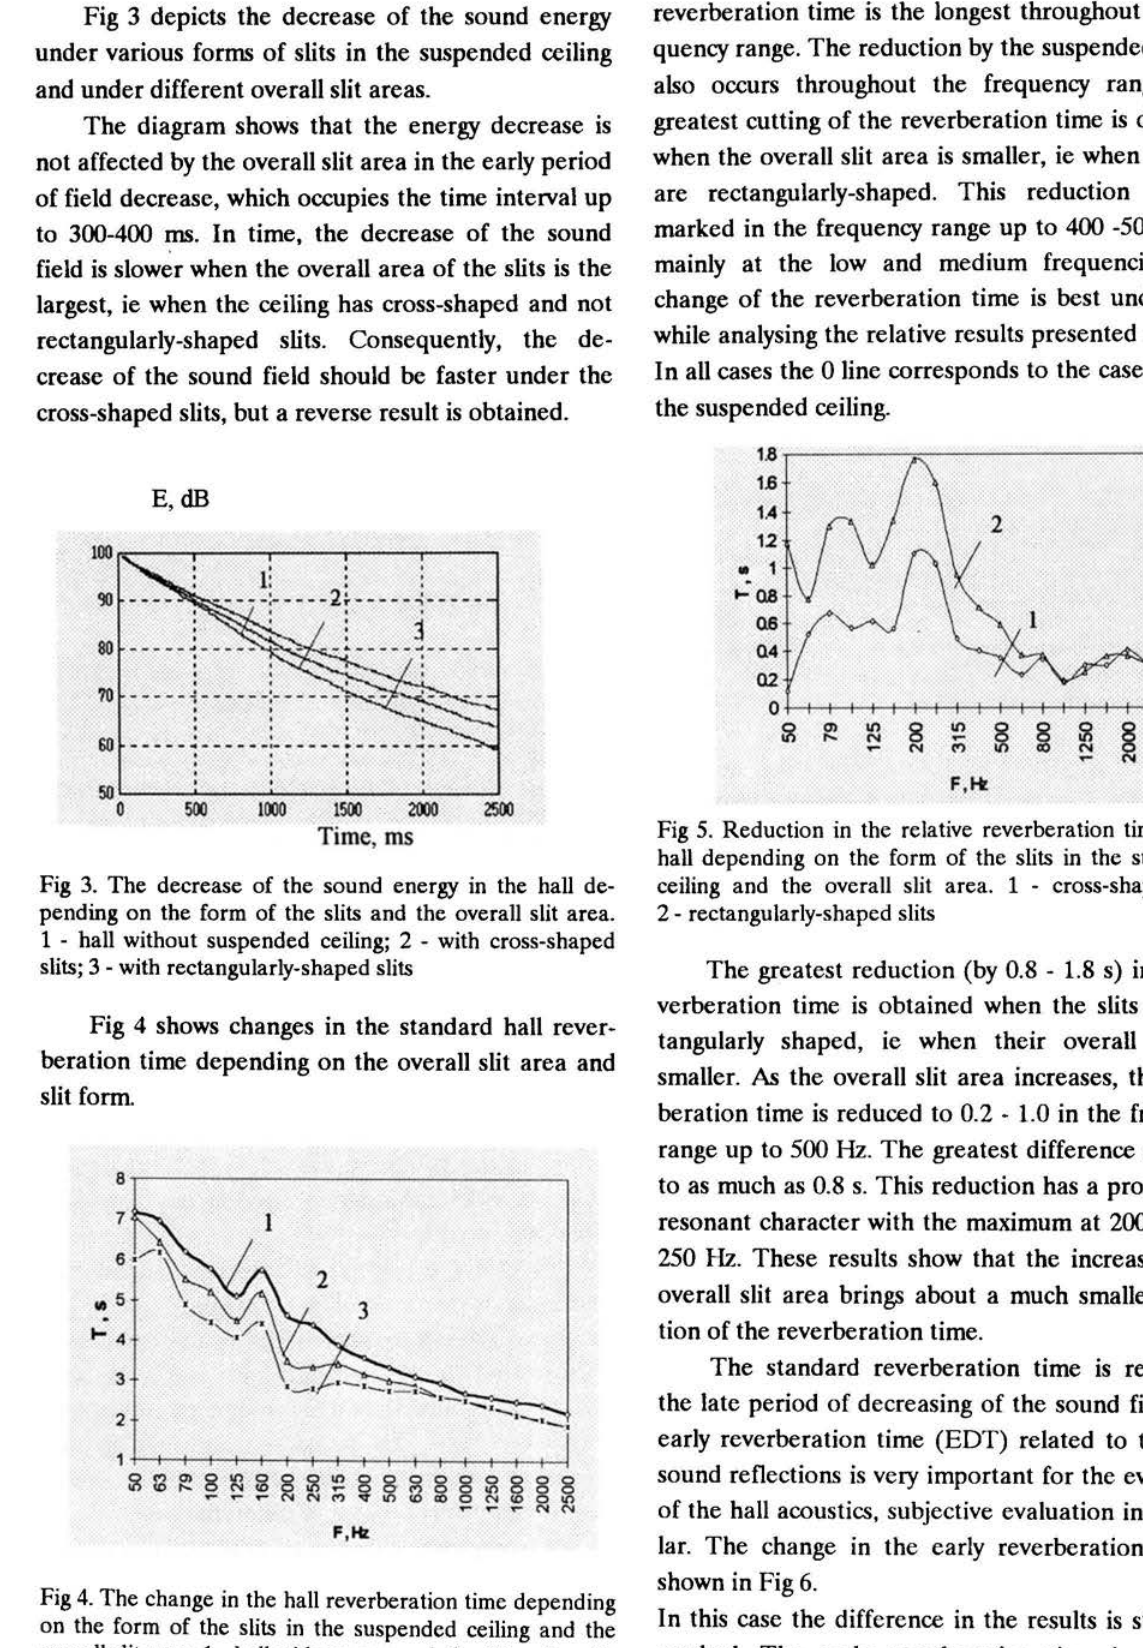
Fig 4. The change in the hall reverberation time depending on the form of the slits in the suspended ceiling and the overall slit area. 1 - hall without suspended ceiling; 2 - with cross-shaped slits